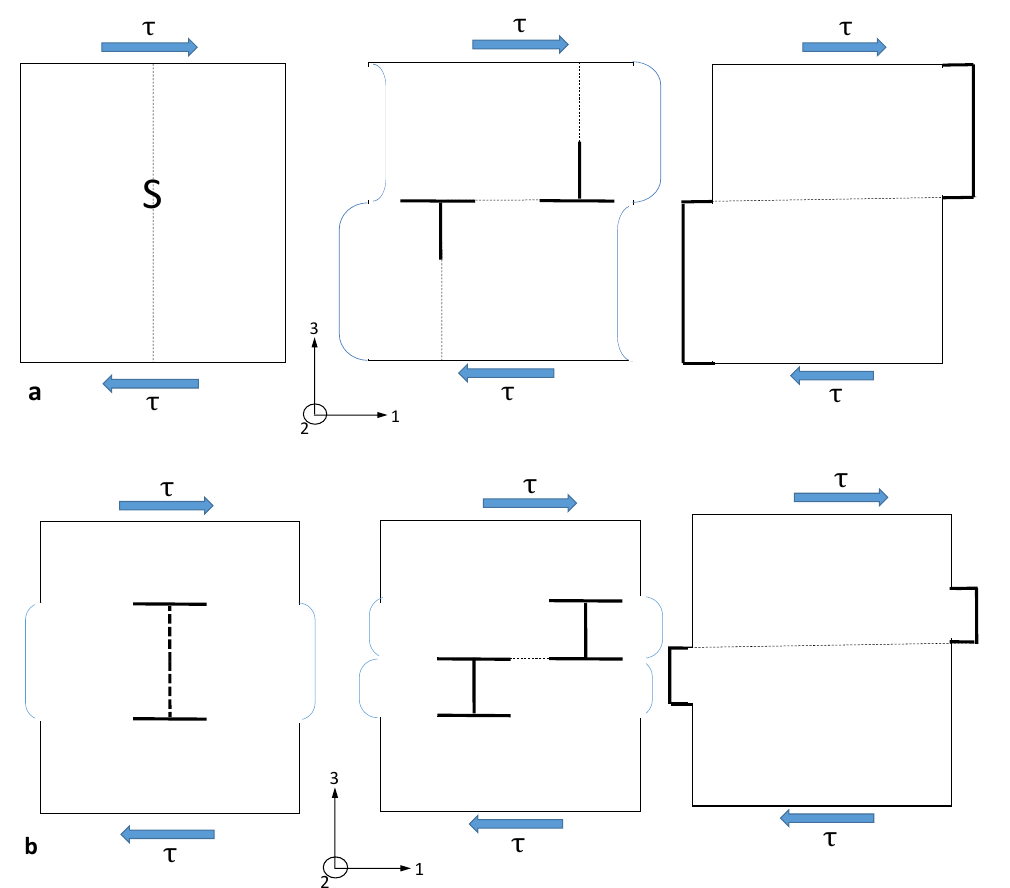
Figure 34. Schematic diagrams showing: ( a ) the translation of the extra half planes created by the activation of a shear source (S); and ( b ) hypothetical shear of a prismatic interstitial loop. Both views are projections perpendicular to the direction of the Burgers vector. The elastic strains at the surface of the crystal are indicated by the light blue brackets.